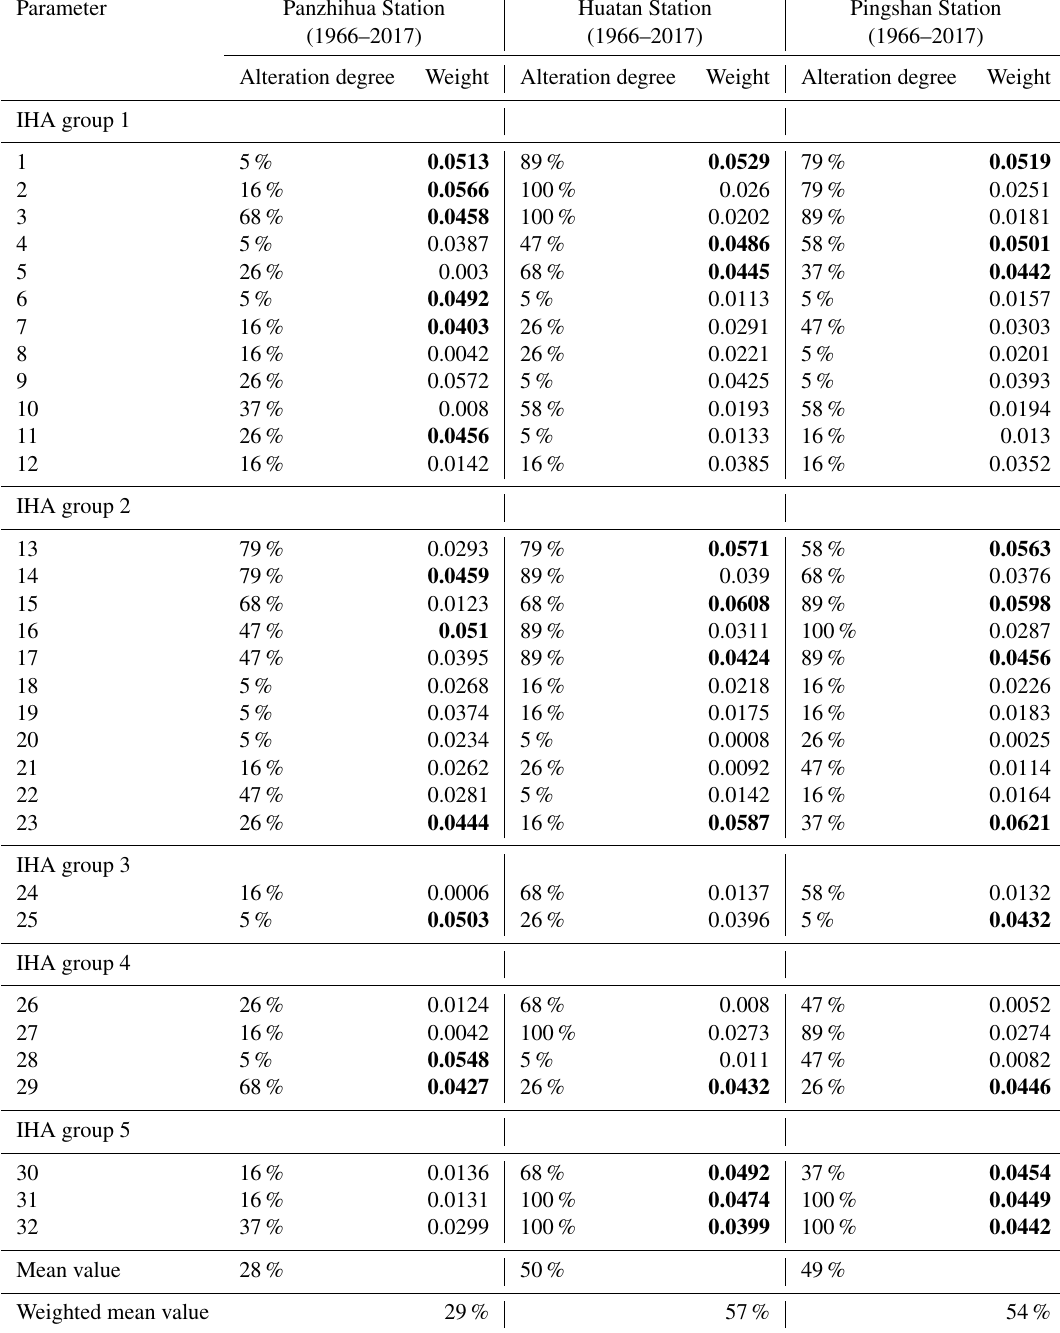
Table 4. Alteration degree and weight of 32 IHA